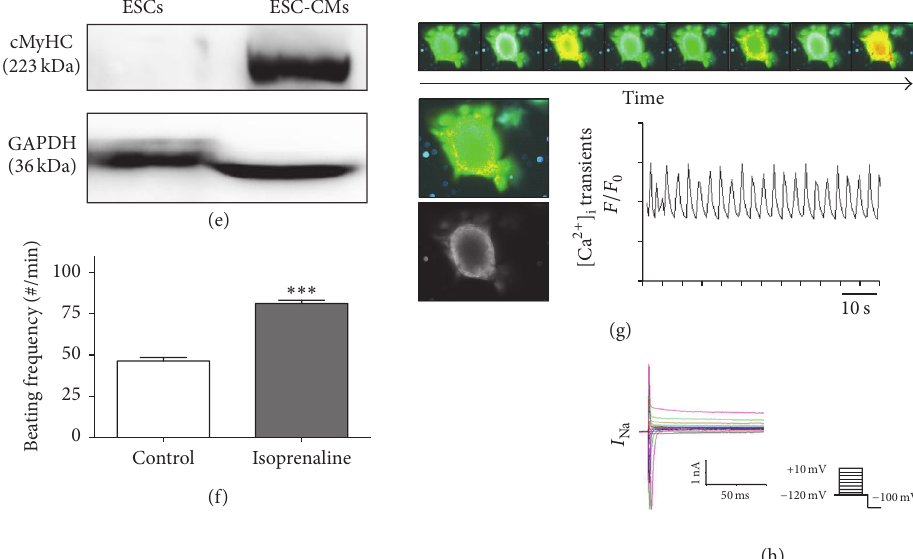
Figure 1: Characterization of the embryoid body- (EB-) based cardiac differentiation protocol. Characterization was performed on human embryonic stem cell-derived cardiomyocytes (ESC-CMs) without the addition of Activin A (ActA) during the early stage of differentiation (control condition). (a) Schematic representation of the EB-based cardiac differentiation protocol. (b) Expression profiles for pluripotency ( OCT4 and NANOG ), mesodermal ( BRACH ), cardiac progenitor ( NKX2.5 and GATA4 ), and late-stage CM ( cMyHC , TNNT2 , TNNI3 , and HCN4 ) markers, monitored during 19 days of differentiation. (c) IF analyses of dissociated EBs at day 20 of differentiation, showing areas of connected CMs (cMyHC; red) expressing connexin 43 (CX43; green). Nuclei were stained with Hoechst (blue). (d) Flow cytometry analyses of cMyHC + CMs at day 20 of differentiation. Representative example of three independent experiments. (e) Western blot analyses quantifying thecMyHCproteinlevelsofundifferentiatedESCsandCMsafter20daysofdifferentiation,normalizedbyGAPDH.(f) 𝛽 -Adrenergicresponse of CMs to isoprenaline (1 𝜇 M; isoproterenol), triggered at day 20 of differentiation. (g) Time course of intracellular Ca 2+ handling at day 20 of differentiation, using the Ca 2+ -sensitive fluorescent indicator Fluo-4 (2.5 𝜇 M), monitored by confocal microscopy. (h) Whole-cell Na + recording, accessed by applying 500 ms voltage pulses to potentials between − 120 and +10mV in 5mV increments from a holding potential of − 100mV at 0.5 Hz. RT-QPCR data are represented as Δ C 𝑡 , normalized for the housekeeping genes GAPDH , HPRT , and RPL13a . Data are representative of three independent experiments and values are expressed as mean ± standard error of the mean (SEM). Significant difference is versus control and indicated as 𝑃 < 0.001 : ∗∗∗ . Scale bar = 100 𝜇